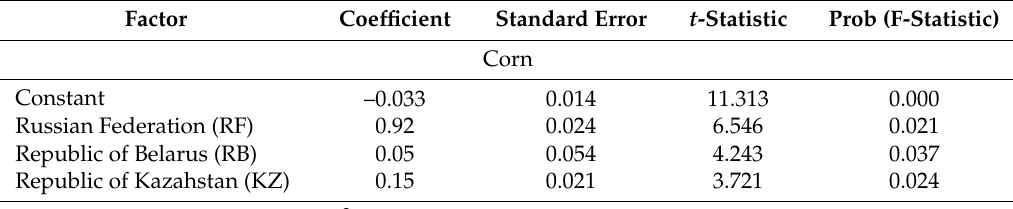
Table 6. The results of the comparison of the EAEU countries in the level of competitiveness of corn based on regression analysis from 2010 to 2016.